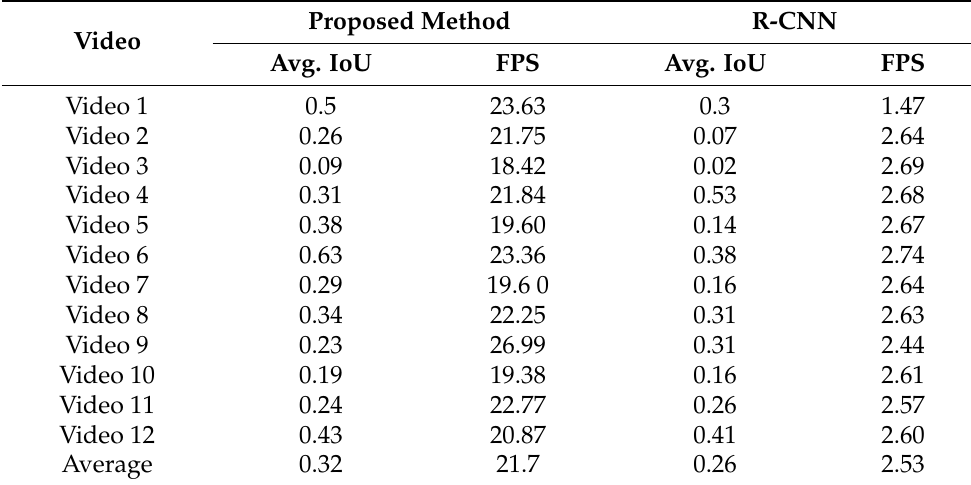
Table 7. Evaluation based on IoU Rate and Computation